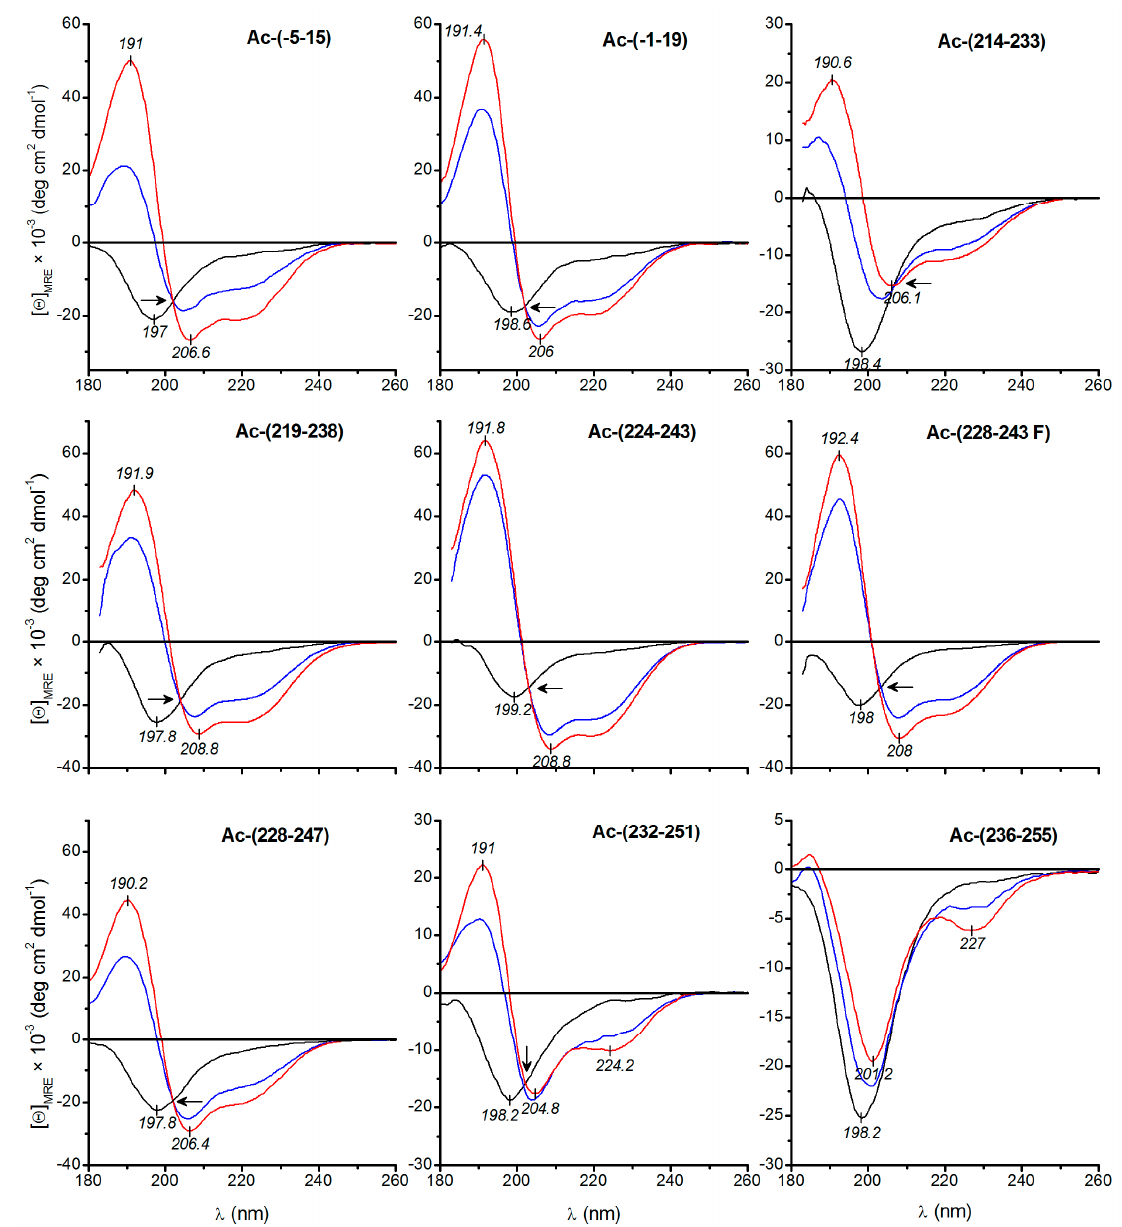
Figure 3. Far-UV CD spectra of HSV peptides measured in water (black), TFE (red) and water:TFE (1:1 v/v) mixture. Arrows denote isodichroic points at λ ~203 nm. For Ac-(214–233), the isodichroic point is shifted to λ = 206 nm.